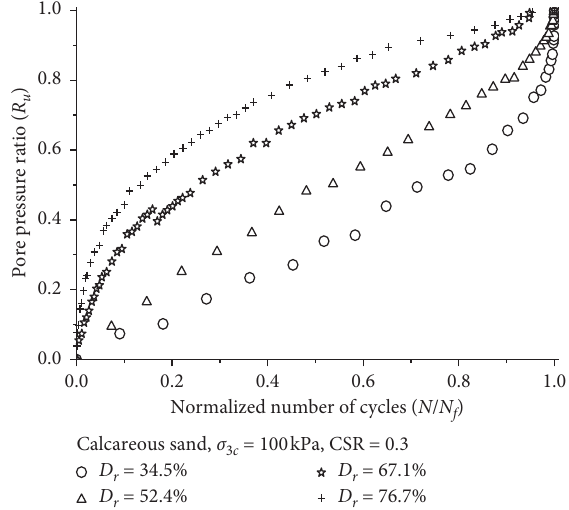
Figure 13: Effect of D r on the pore pressure growth curve of calcareous